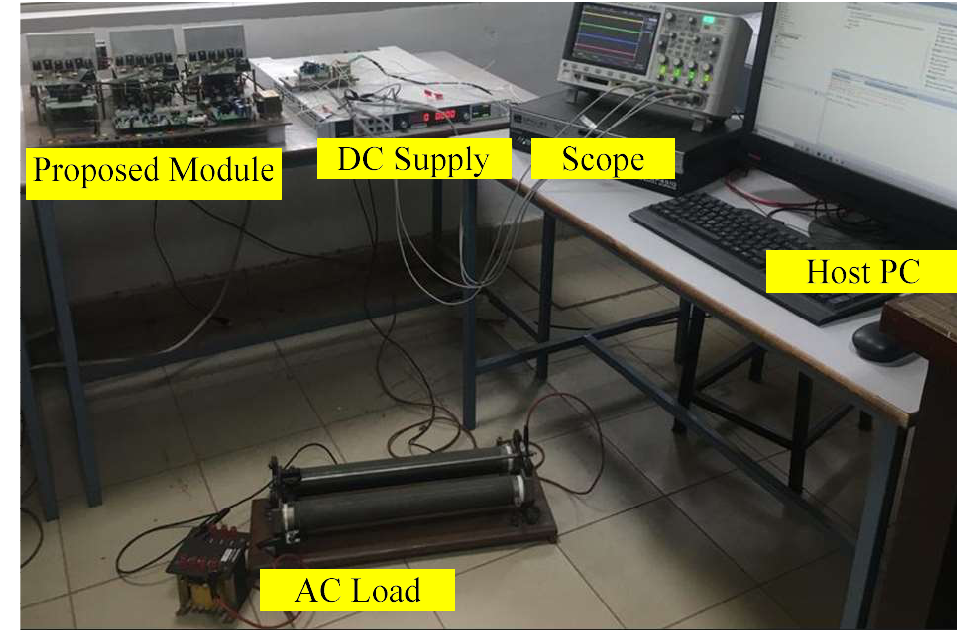
Figure 6. Experimental setup.